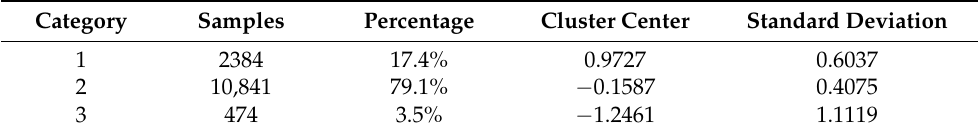
Figure 4. Cluster distribution of pupil diameter change rate. Table 3. Clustering distribution of pupil diameter change